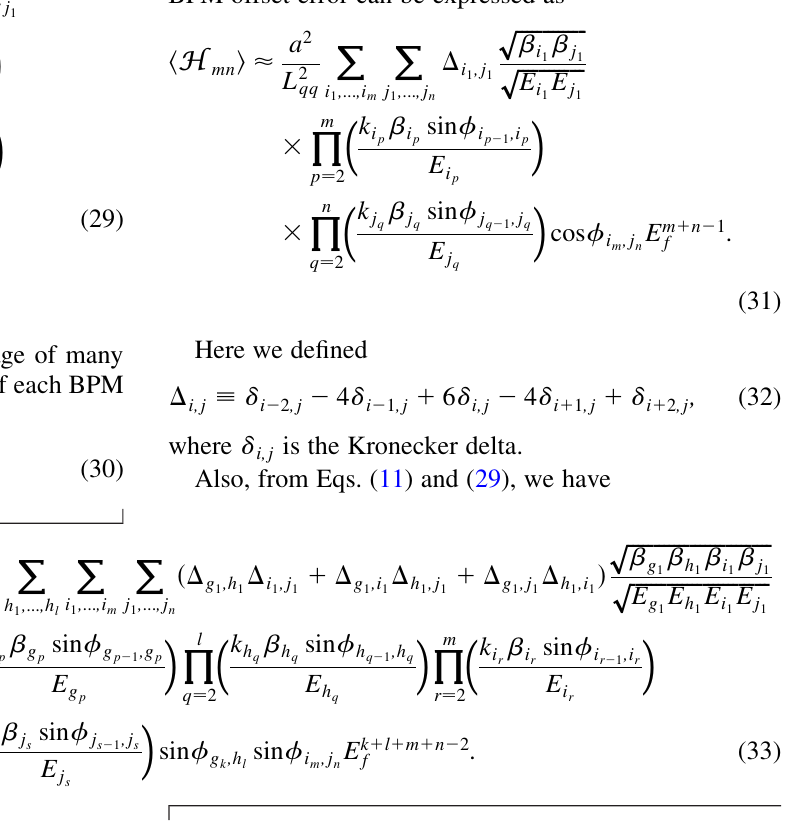
ffiffiffiffiffiffiffiffiffiffiffiffiffiffi (cid:6) (cid:6) i 1 j 1 ffiffiffiffiffiffiffiffiffiffiffiffiffi E E i 1 j 1 ffiffiffiffiffiffiffiffiffiffiffiffiffiffi